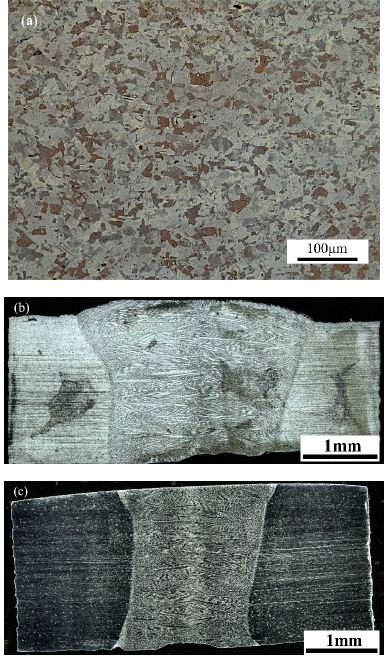
Figure 1. A microstructure of ( a ) the TWIP steel and welded joints, under different welding speeds: ( b ) 1.5 m/min and ( c ) 2.5 m/min.